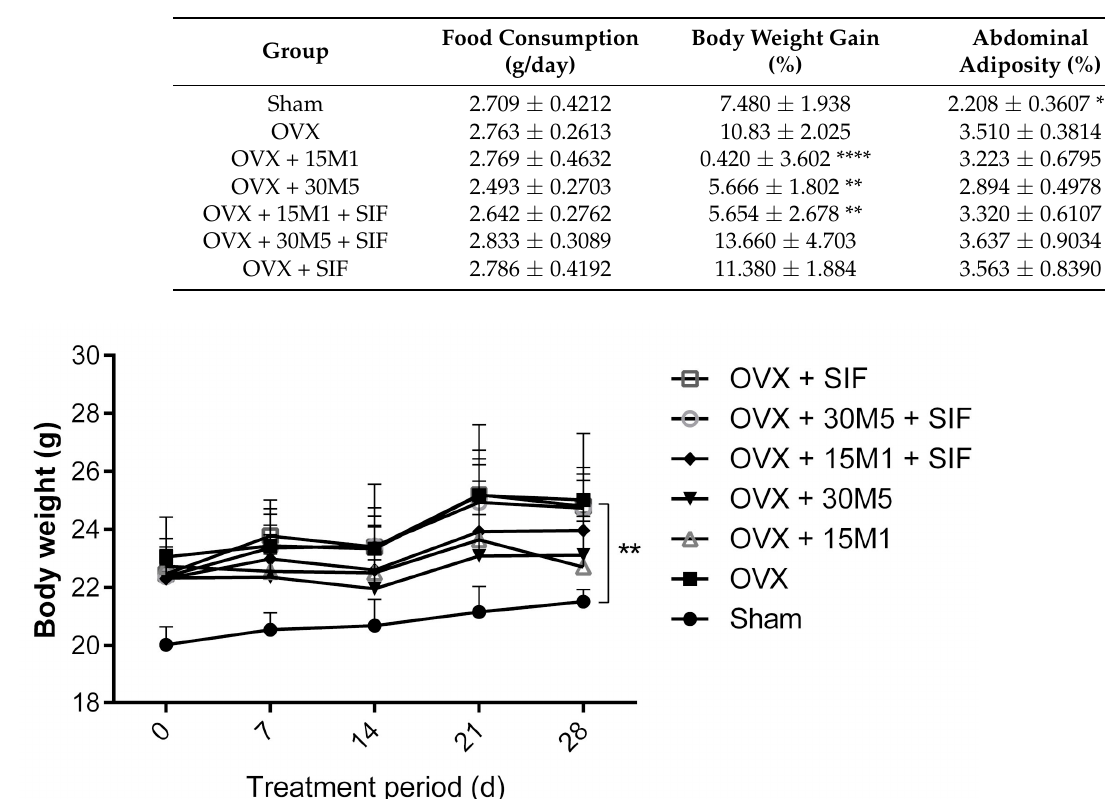
Table 2. Body and food consumption parameters. Body weight gain (%) = (body weight (grouping day 30) − body weight (grouping day 0)) / body weight (grouping day 0). Abdominal adiposity (%) = weight of abdominal adiposity/ final body weight. Data presented as mean ± standard deviations (SD) for variables with normal distribution or median-interquartile range (Q1 – Q3) for variables not normally distributed. * p < 0.05, ** p <0.01, **** p <0.0001 vs. OVX.